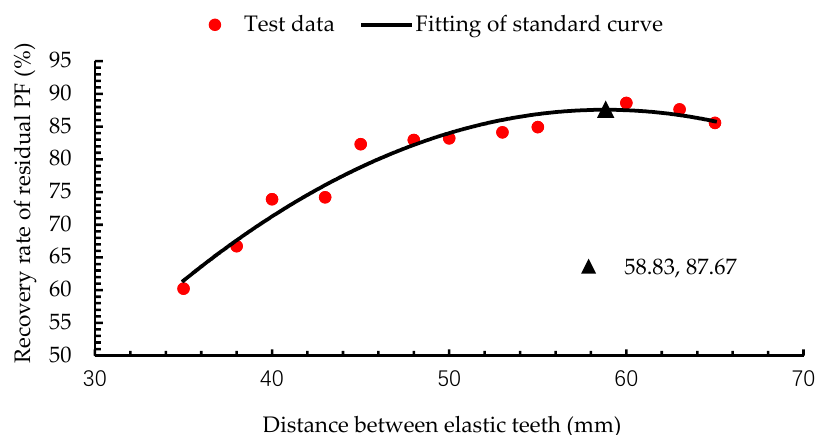
Figure 9. The relation between the observed and predicted recovery rate of residual PF (%).